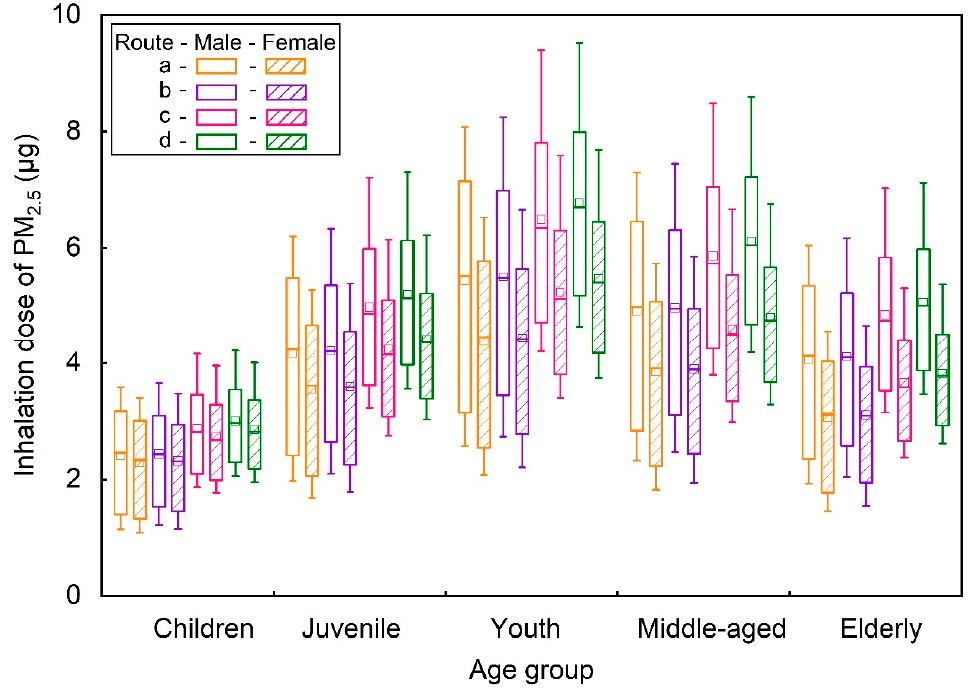
Figure 8. PM 2.5 inhalation intakes in the metro carriage. Data shown in the box plot are the minimum, maximum, the 1st and 3rd quartile, median (solid line), and arithmetic average values (square).